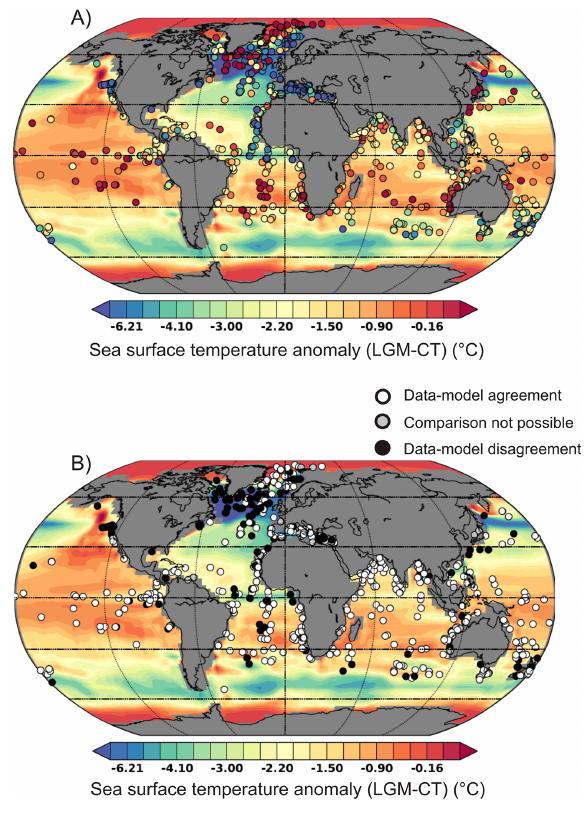
Figure 5. (a) Comparison between simulated SST anomaly (LGM- CT) in i LOVECLIM and MARGO data (MARGO Project Mem- bers, 2009). (b) Quantitative agreement or disagreement between simulated SST anomaly (LGM-CT) in i LOVECLIM and MARGO data (MARGO Project Members, 2009), taking into account the uncertainties on SST reconstructions. Grey points (comparison not possible) denote the absence of error bars on data or denote loca- tions where model results are not comparable to data (coastal sites). For colour scale generation explanations see Fig. 1